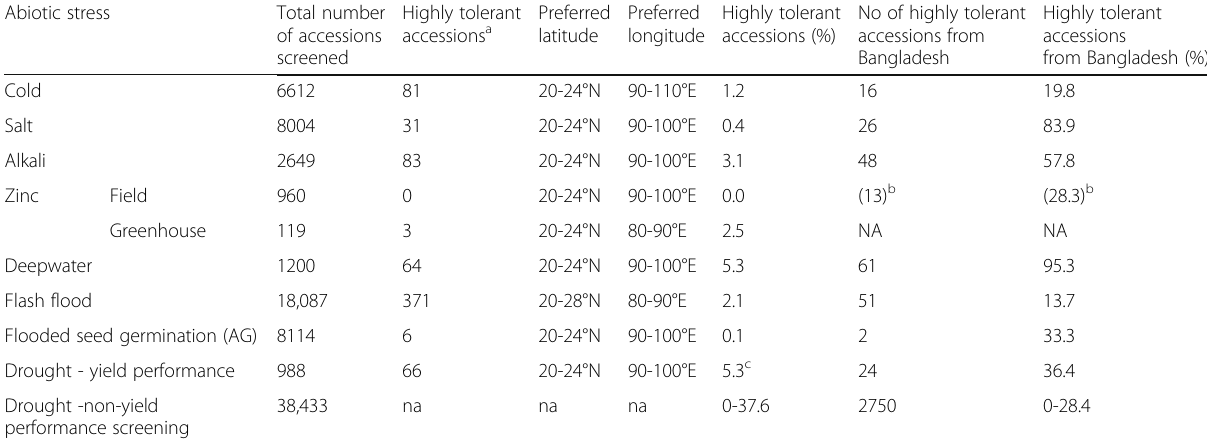
Table 2 Preferential Geographic Distribution Pattern of Abiotic Stress Tolerant Rice Accessions Abiotic